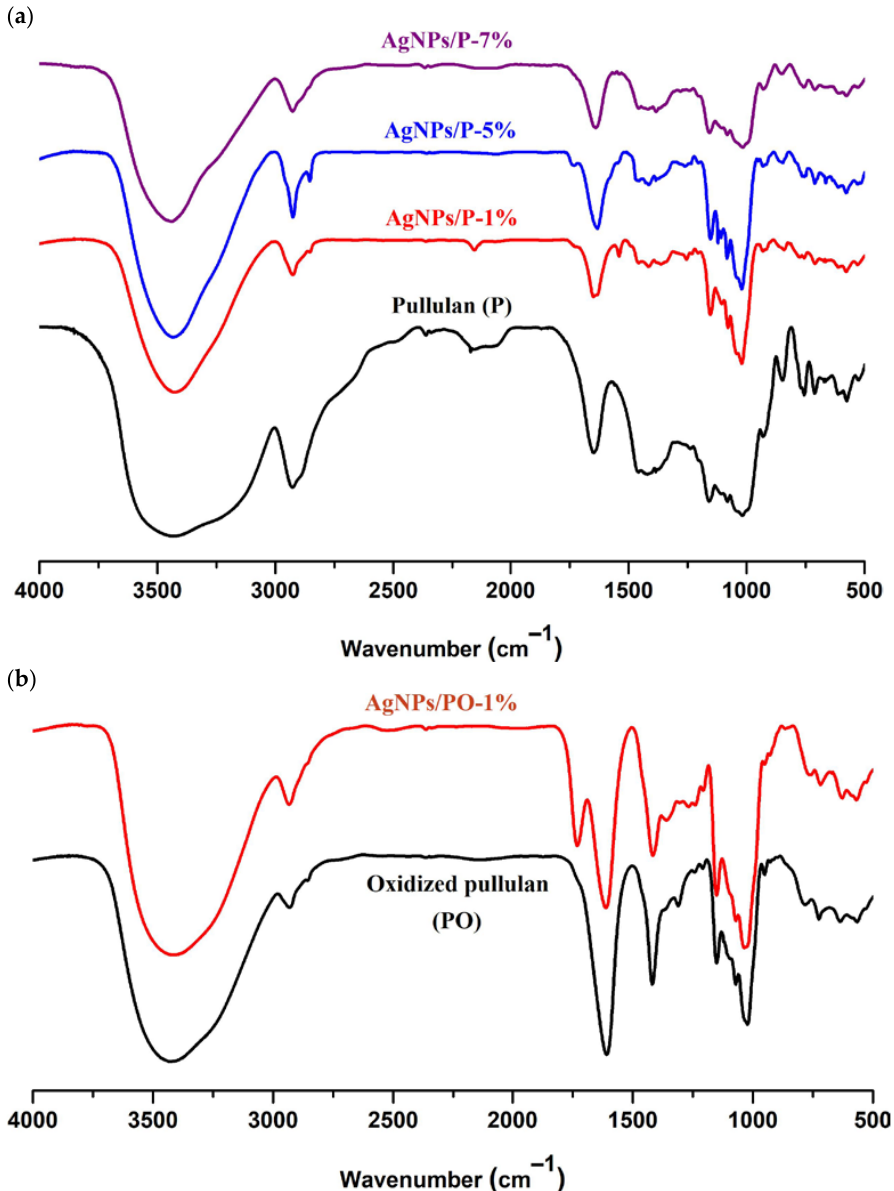
Figure 3. FTIR spectra of pullulan (P) and silver nanoparticles stabilized by P ( a ), and oxidized pullulan (PO) and silver nanoparticles stabilized by PO samples ( b ).